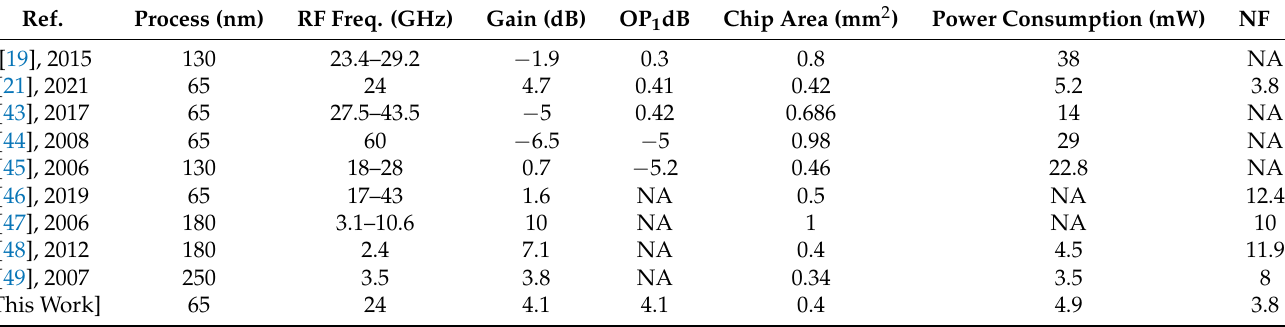
Table 2. Comparison summary for recently reported